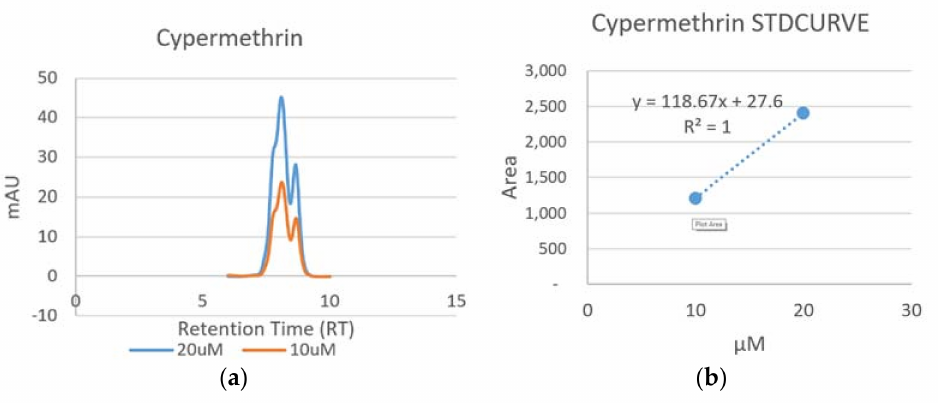
Figure 1. Chromatogram ( a ) and standard curve ( b ) of